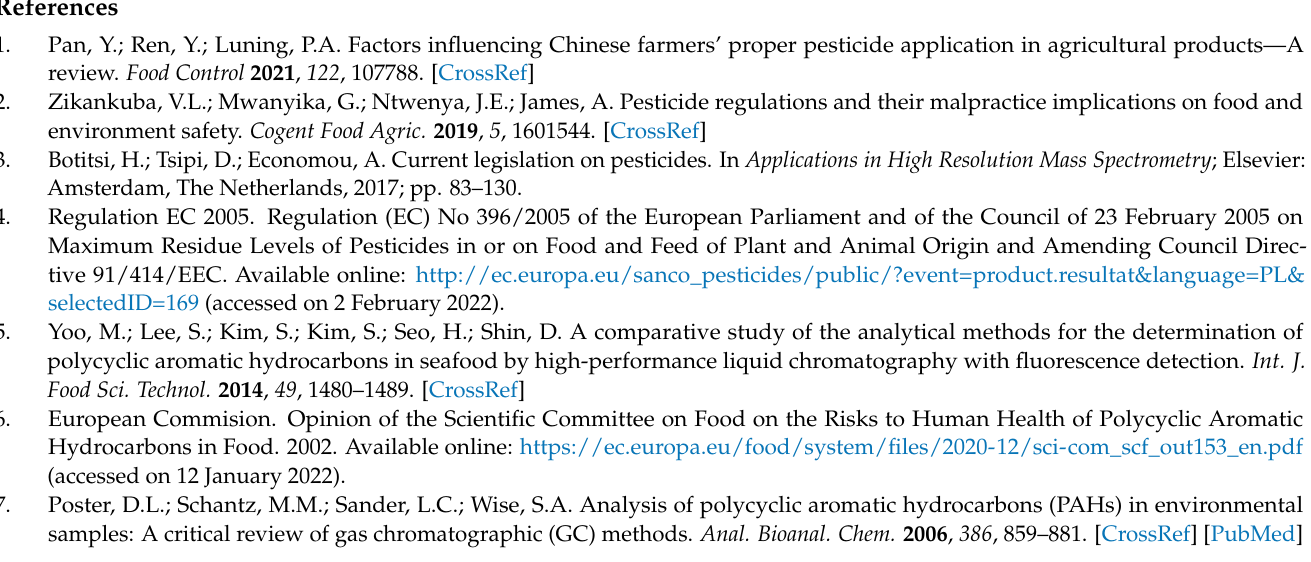
matogram for the blank sample—lettuce matrix. Figure S8. Chromatogram for the fortified sample (level 1.00 mg/kg)—lettuce matrix, selected pesticides (Rt: 12.195—Pencycuron;